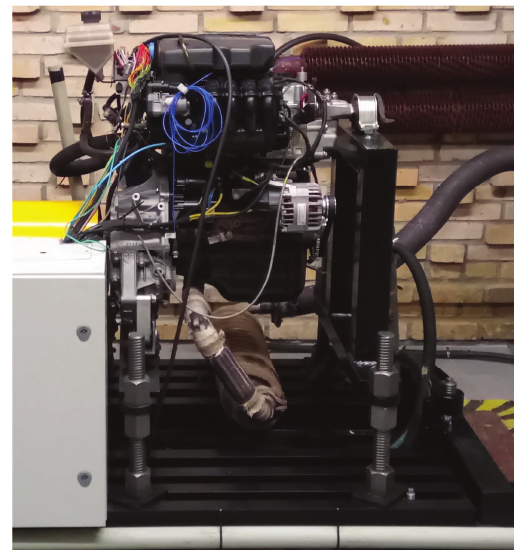
Fig. 3. The engine test station, Fiat